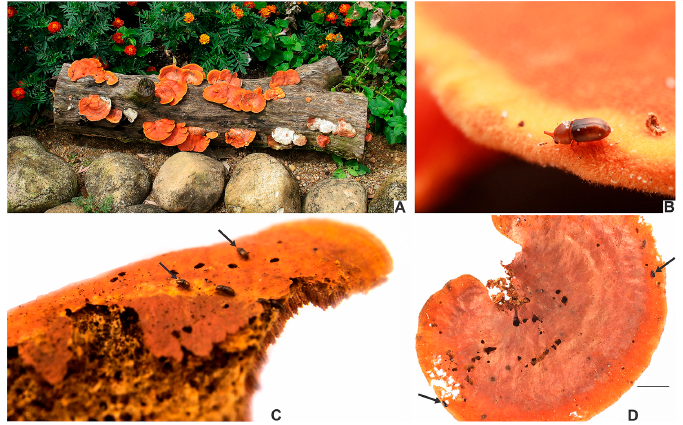
Figure 1. Pycnoporus sanguineus (L.) Murrill, host fungus of species of the furcifer group. ( A ) Figure 1. Basidiomes at a garden in Juiz de Fora, Minas Gerais (MG), Brazil. ( B ) A male of C. cornifer (Mellié) species on a P. sanguineus basidiome from Serra do Cipó, MG, Brazil. C − D Basidiomes colonized ( C ) by individuals of Ceracis cornifer (Mellié) from Juiz de Fora (arrows indicating the presence of two) and ( D ) by individuals of Ceracis furcifer Mellié from Araguaína, Tocantins (TO), Brazil (arrows). Figure 1D, scale bar = 0.5 mm.